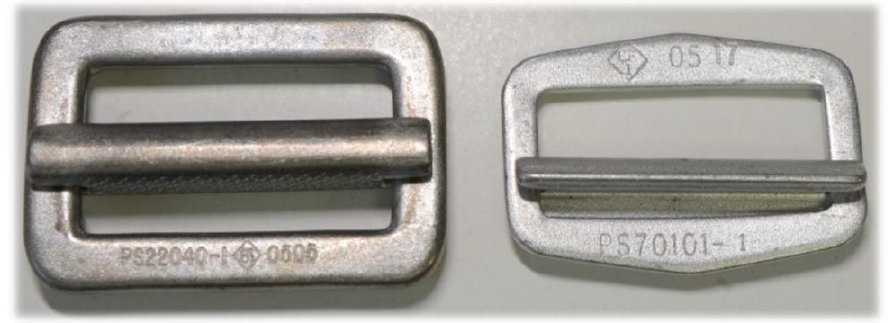
Figure 2. Selected buckles for the frame preparation to create the measuring load cell.